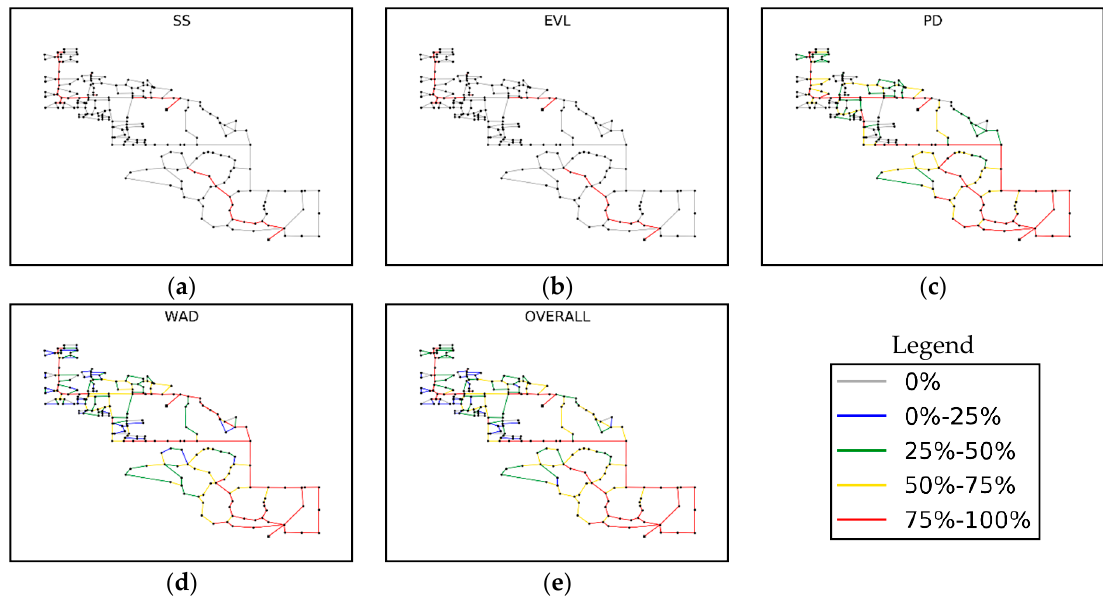
Figure 3. Critical pipe assessment for ( a ) supply shortage ( SS) , ( b ) economic value loss ( EVL) , ( c ) pressure decline ( PD) , ( d ) water age degradation ( WAD) , and ( e ) OVERALL of Network 1.